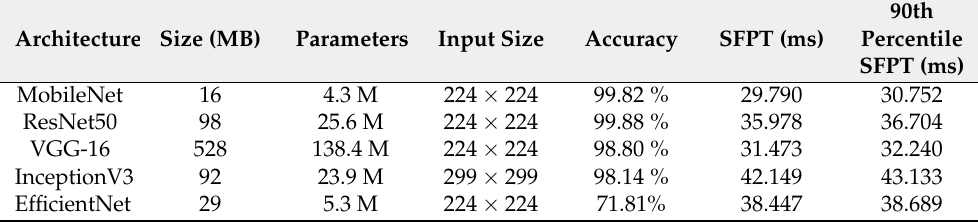
Table 6. Accuracy and speed performance obtained with Neural Network classifiers. Experimental results can also be considered in relation to the size and number of parameters of each neural network. Architecture Size (MB)